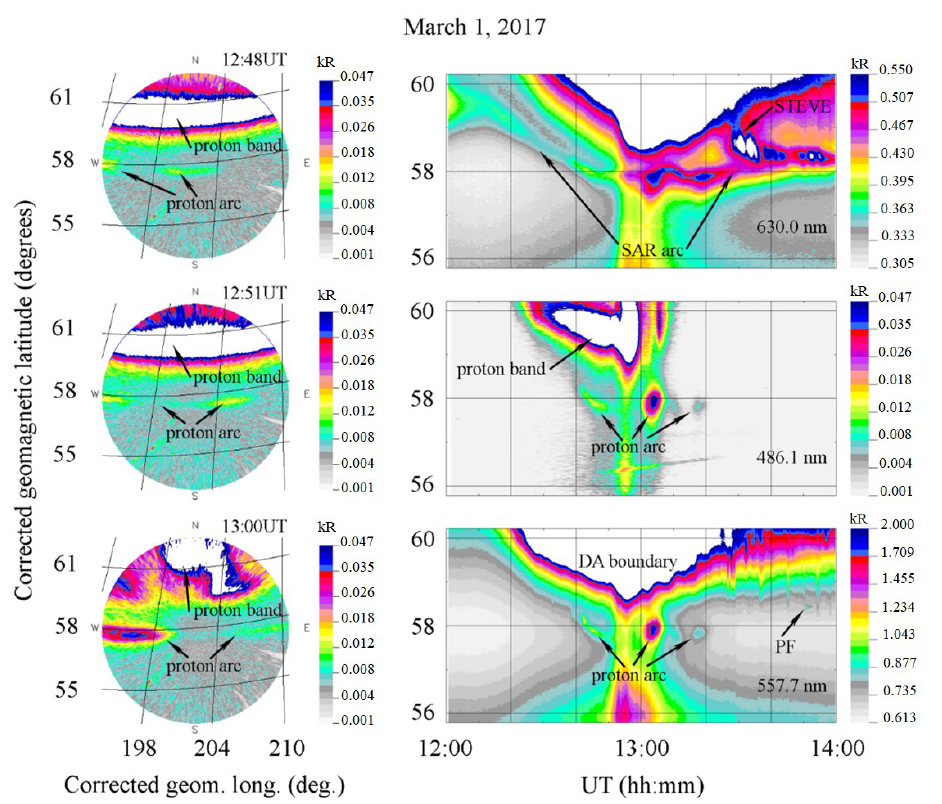
Fig. 2. Dynamics of subauroral luminosity at Maimaga station during observations on March 1, 2017. On the left side of the figure are images of all sky in emission of 486.1 nm for three points in time indicated in the images. The right side of the figure shows the latitudinal dynamics of the luminosity in the 630.0, 486.1, and 557.7 nm emissions in the form of keograms. All sky images and keograms projected onto the Earth's surface for luminosity heights of 110 km for emissions of 486.1 and 557.7 nm and 250 km for emissions of 630.0 nm. The signal intensity is given in kilo rayleighs.